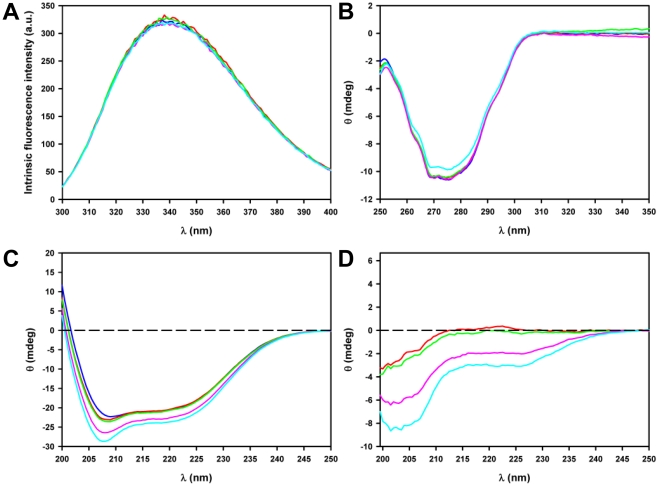
PolyQ insertions have no effect on the structure of BlaP.(A) Intrinsic fluorescence, (B) near-UV CD and (C) far-UV CD spectra of BlaP (blue) and the chimeras with 23 (red), 30 (green), 55 (pink) and 79 (cyan) glutamines. a.u., arbitrary units. (D) Difference spectra obtained by subtraction of the far-UV CD spectrum of BlaP from that of each chimeric protein. Spectra were recorded at 25°C in PBS, pH 7.5, using protein concentrations of 4.6 µM (fluorescence and far-UV CD) and 20 µM (near-UV CD).